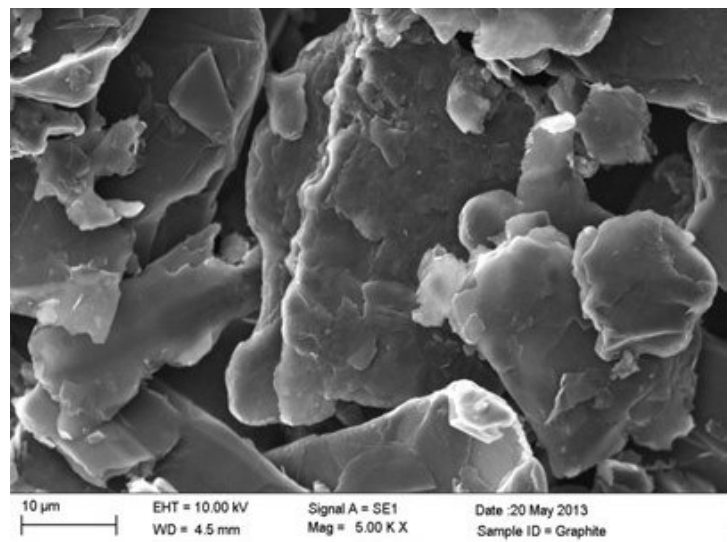
Figure 1. SEM images of as received-graphite.